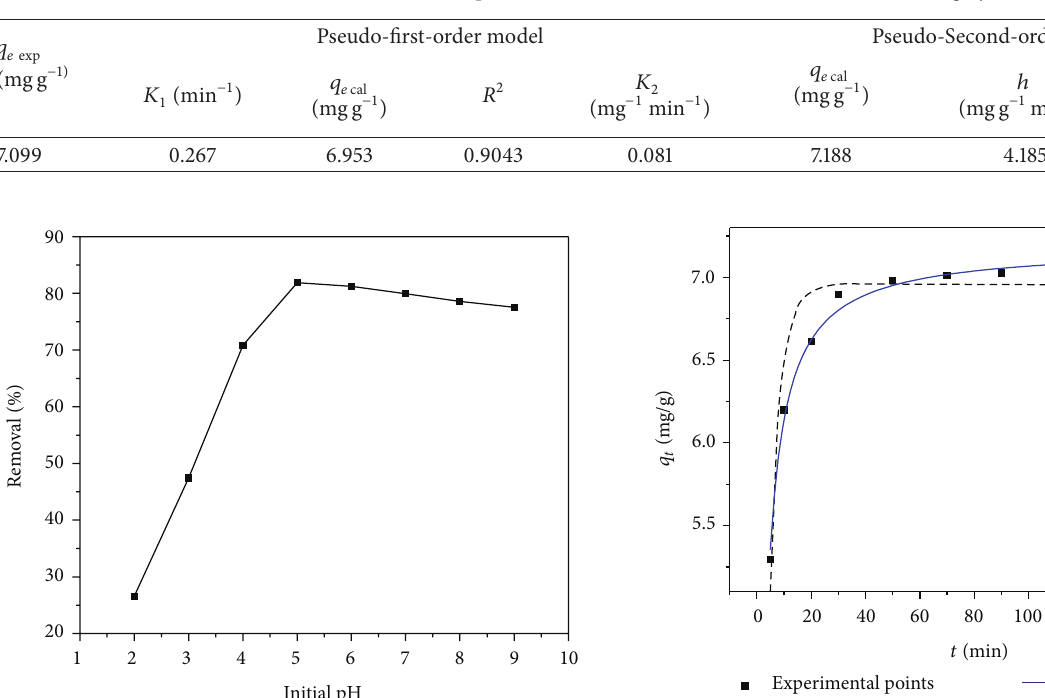
Figure 3: SEM images of WAS at two different magnifications. Table 2: Pseudo-first-order and pseudo-second order rate constants for Cd(II) binding by WAS.